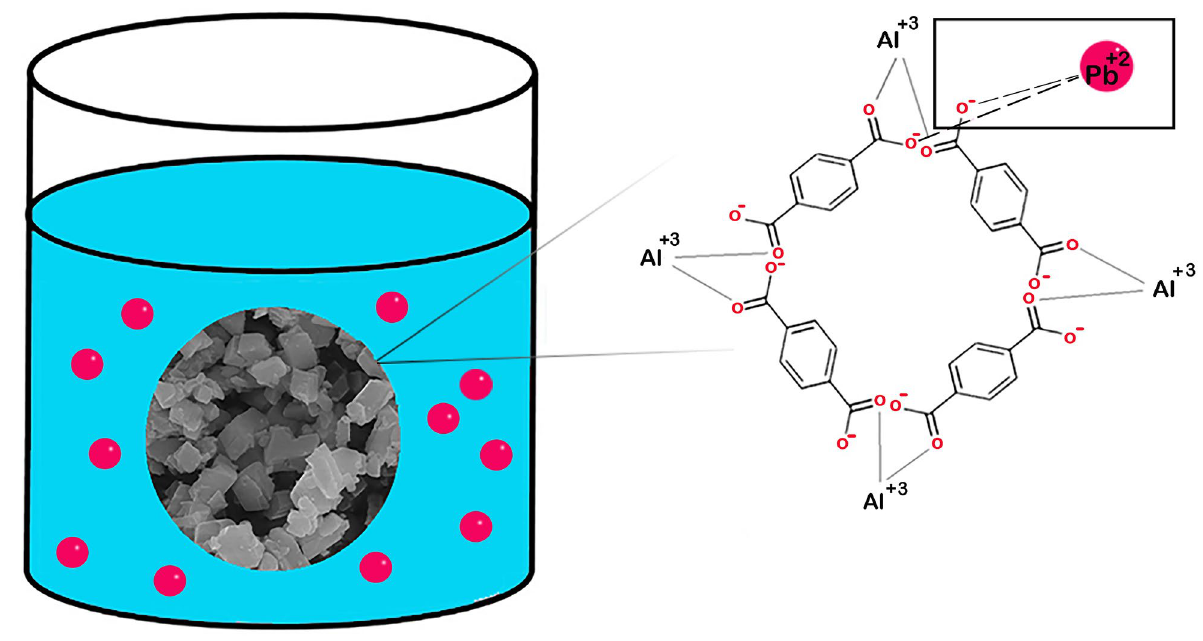
Figure 16. The schematic representation of adsorption mechanism of Pb +2 on UAS